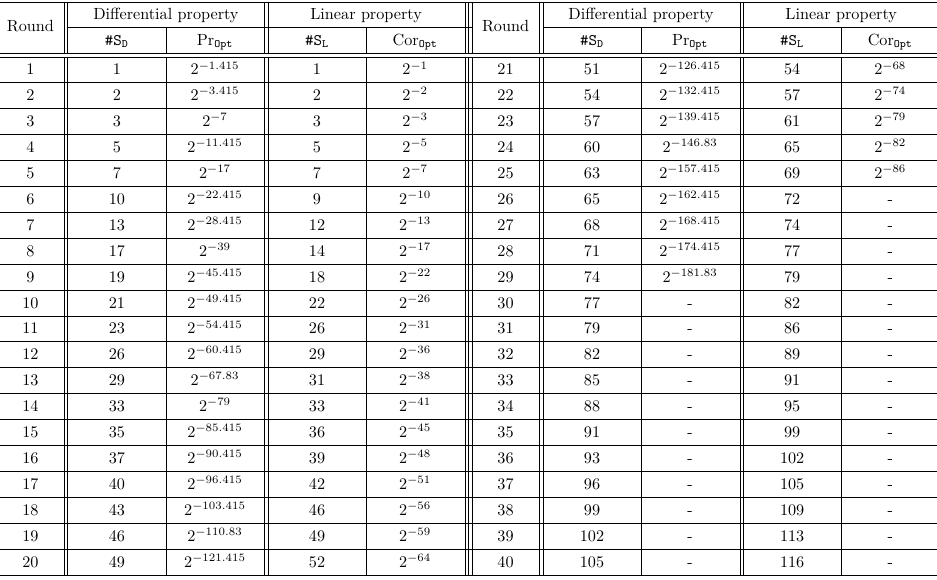
Table 5: Experimental results of GIFT-128